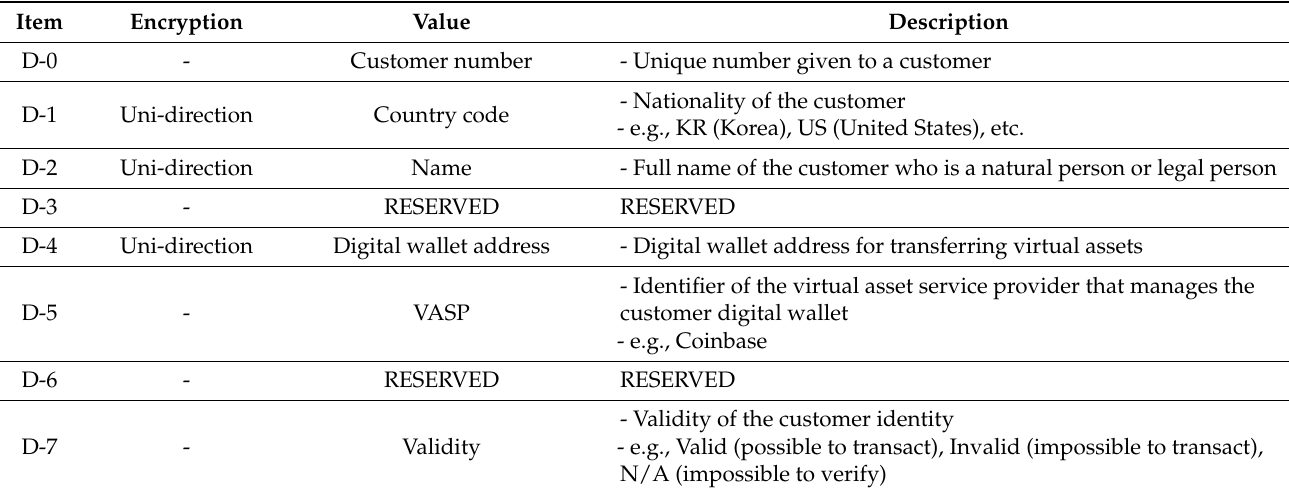
Table 4. Data format-3.